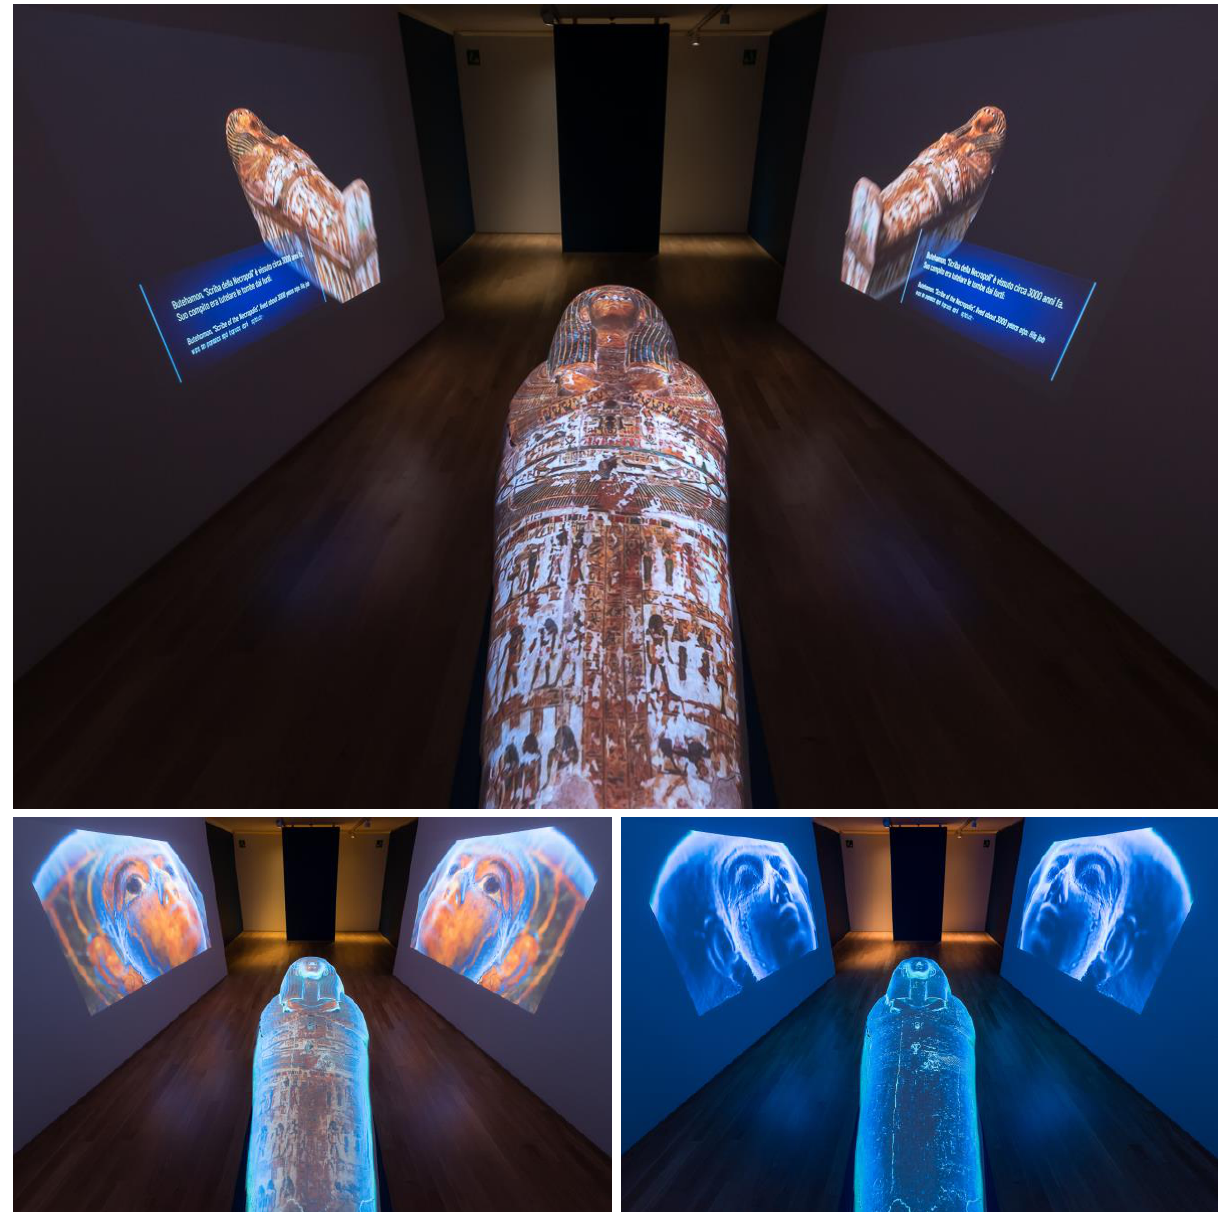
Figure 1. Virtual display of the structure and appearance of the external coffin of Butehamon (Twentieth Dynasty), from the exhibition Archeologia Invisibile, Museo Egizio, Torino, 2019 (photograph by Museo Egizio,